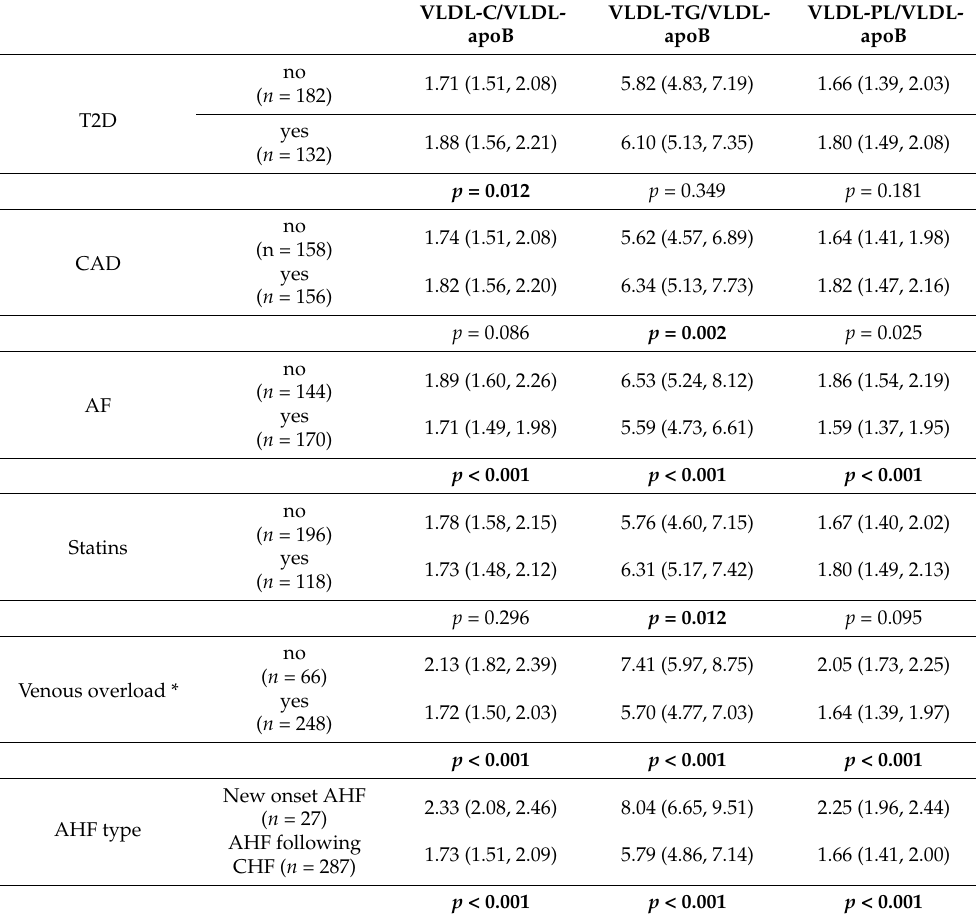
Table 3. The ratios in various groups of AHF